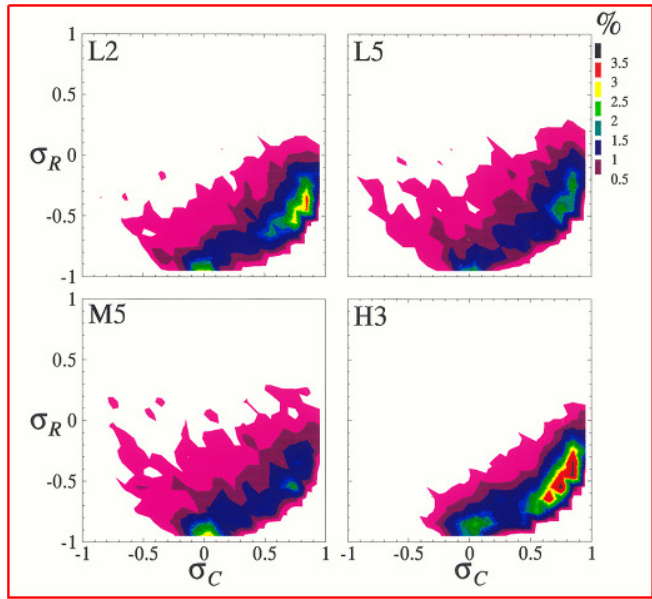
Figure 64: 2D histograms of normalized cross-helicity 𝜎 c (here indicated by 𝜎 C ) and normalized residual energy 𝜎 r (here indicated by 𝜎 R ) for different heliospheric regions (ecliptic wind, mid-latitude wind with strong velocity gradients, polar wind). Image reproduced by permission from Bavassano et al. (1998), copyright by